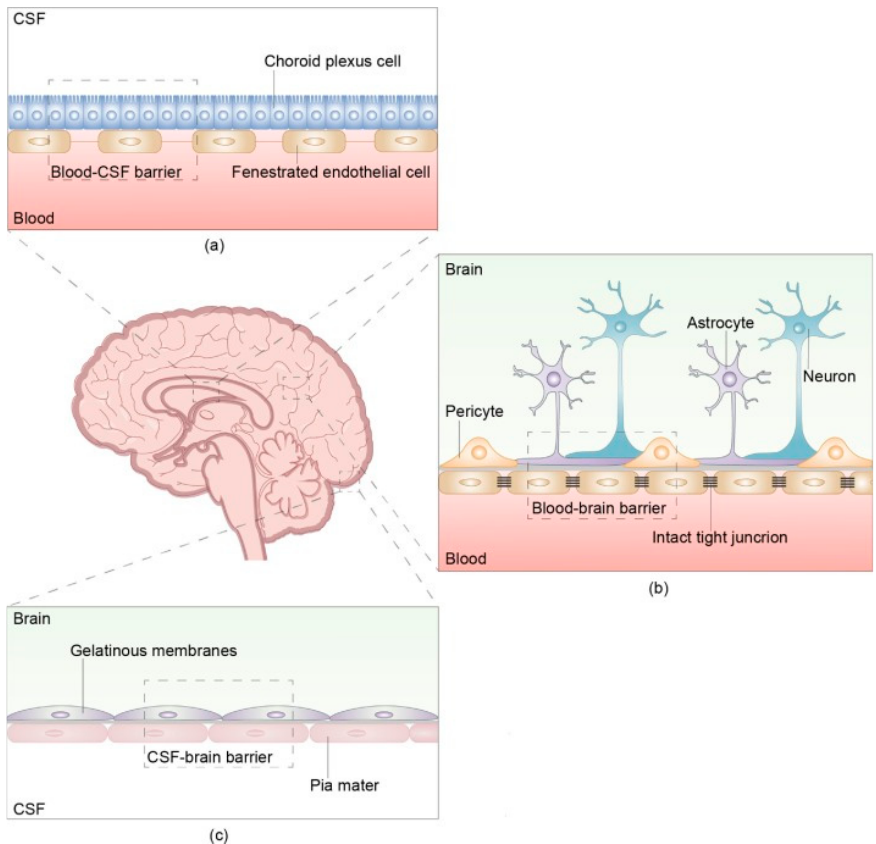
Figure 1. The structure and composition of the brain barrier The brain barrier consists of three parts: the blood- cerebrospinal fluid (CSF) barrier, blood–brain barrier, and CSF-brain barrier. ( a ) The blood-CSF barrier is located between the blood and CSF in the ventricular choroid plexus. ( b )